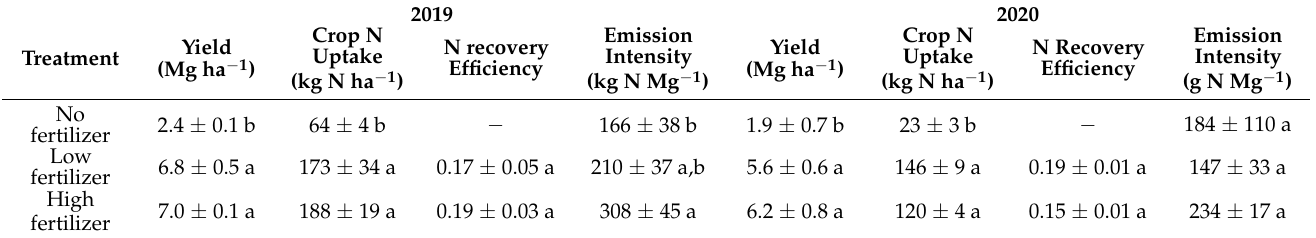
Table 4. Cotton seed yield, crop N uptake, N recovery efficiency, and yield − scaled emission intensity by study year and fertilizer. Values are the means ± 1 standard error, n =